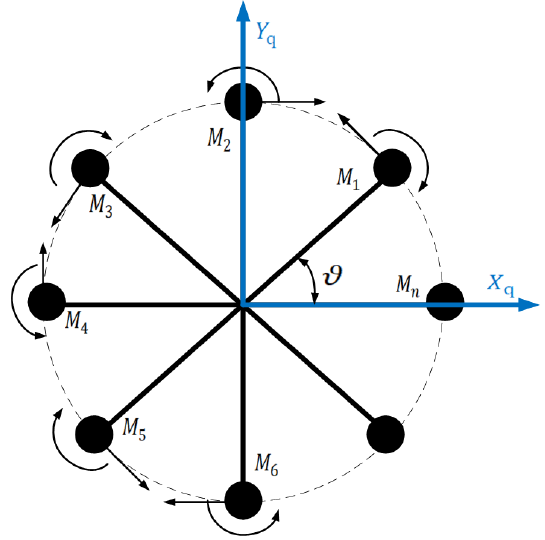
Figure 3. Motors configuration.